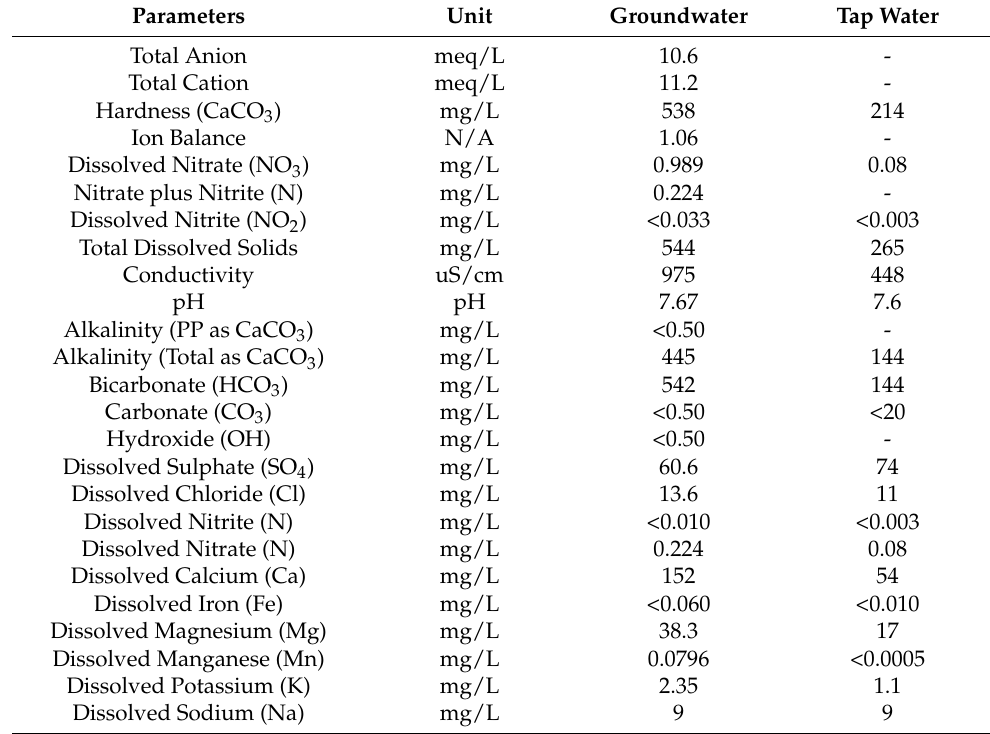
Table 3. Characteristics of groundwater and tap